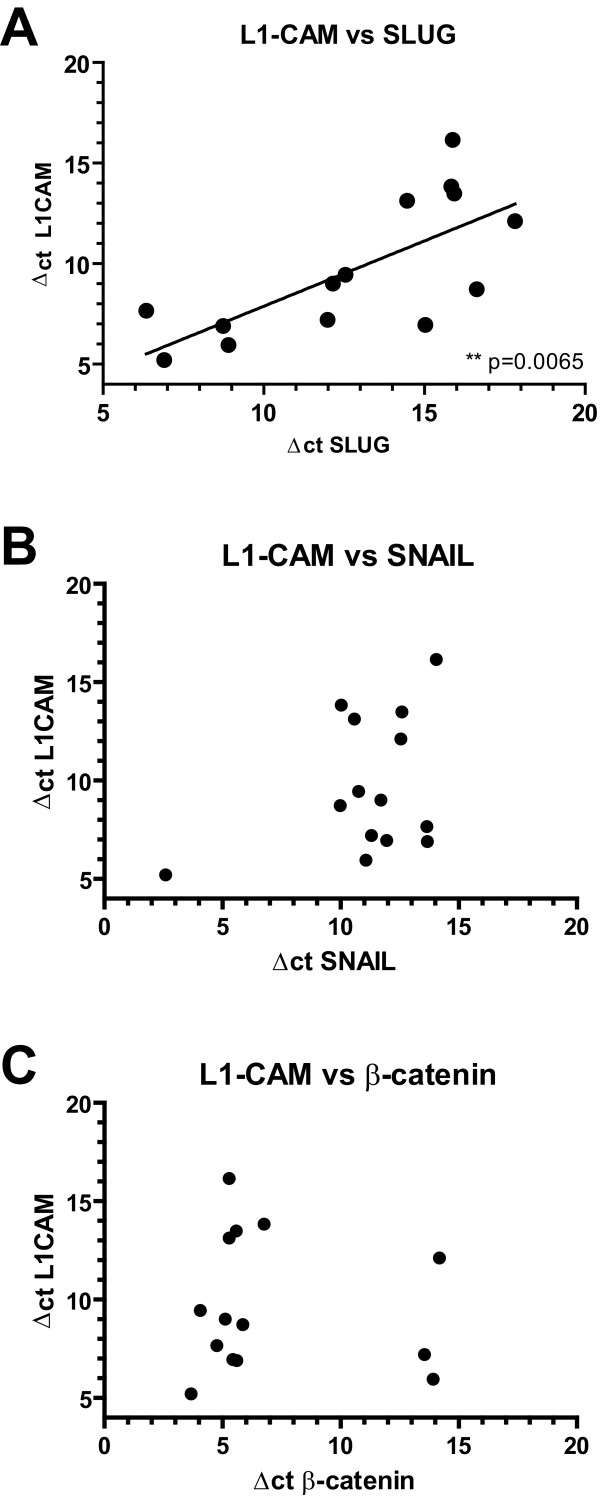
Correlation of L1CAM and various transcription factors in EC cell lines. Δct values using β-actin as standard were determined by qRT-PCR analysis in each cell line for L1CAM, Slug, β-catenin and Snail. The EC cell lines included were: Ishikawa, AN3CA, ARK 1, ECC-1, Hec-1A, Hec-1B, Hec-155, IK ER-, MFE 319, RL-95 2, SNG II, SNG M, SPAC-1L, SPAC-1 S. (A) L1CAM versus Slug. (B) L1CAM vs. Snail; (C) L1CAM vs. β-catenin. Note that low Δct values mean high expression of the respective mRNA. A representative experiment from n = 3 is shown.